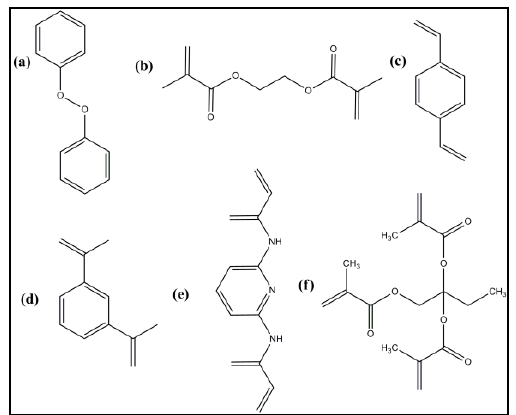
Figure 6. Chemical structures of common cross-linkers for MIP: ( a ) dicumyl peroxide (DCP); ( b ) ethylene glycol dimethacrylate (EGDMA); ( c ) divinylbenzene (DVB); ( d ) 1,3-diisopropenyl benzene; ( e ) 2,6-biscryloylamidopyridine; ( f ) trimethylpropane trimethacrylate (TRIM).